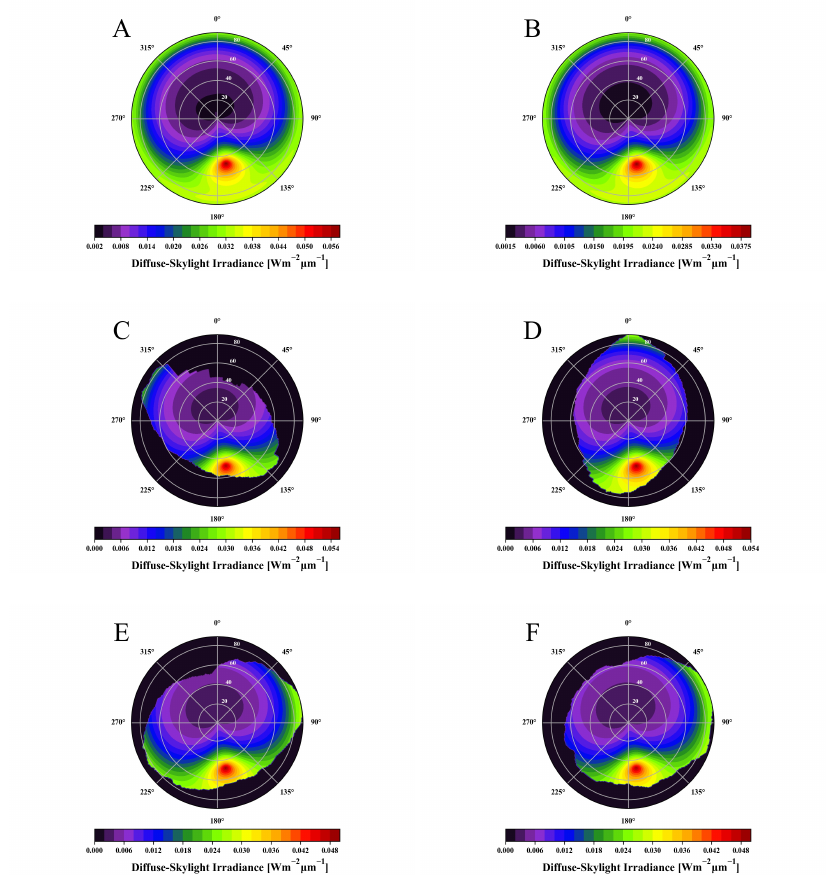
Figure 4. Simulated anisotropic diffuse-skylight irradiance ( E d ; λ = 0.56141 µ m) over the Nanga Parbat Massif. Simulations do not account for local topographic conditions. ( A ). E d in the In- dus Valley ( ϕ = 35 ◦ 25 (cid:48) 21.288808 (cid:48)(cid:48) ; λ l = 74 ◦ 15 (cid:48) 28.975978 (cid:48)(cid:48) ; Integrated E d = 446.8952 W m − 2 µ m − 1 ). Simulation does not account for topographic shielding. ( B ). E d at the top of Nanga Parbat ( ϕ = 35 ◦ 14 (cid:48) 17.959960 (cid:48)(cid:48) ; λ l = 74 ◦ 35 (cid:48) 21.994192 (cid:48)(cid:48) ; Integrated E d = 301.1555 W m − 2 µ m − 1 ). Simu- lation does not account for topographic shielding. ( C ). E d in the Diamir Valley ( ϕ = 35 ◦ 19 (cid:48) 29.8059 (cid:48)(cid:48) ; λ l = 74 ◦ 21 (cid:48) 17.9631 (cid:48)(cid:48) ). Simulation over a V-shaped valley. ( D ). E d in the Raikot valley ( ϕ = 35 ◦ 26 (cid:48) 20.658178 (cid:48)(cid:48) ; λ l = 74 ◦ 35 (cid:48) 58.803448 (cid:48)(cid:48) ). Simulation over a V-Shaped valley. ( E ). E d in the Rupal Valley ( ϕ = 35 ◦ 11 (cid:48) 17.921638 (cid:48)(cid:48) ; λ l = 74 ◦ 35 (cid:48) 58.483795 (cid:48)(cid:48) ). Simulation over a U-shaped valley. ( F ). E d in the Sachen Valley ( ϕ = 35 ◦ 19 (cid:48) 41.854361 (cid:48)(cid:48) ; λ l = 74 ◦ 44 (cid:48) 45.984769 (cid:48)(cid:48) ). Simulation over a U-Shaped valley. All simulations were computed with an average ground reflectance value of